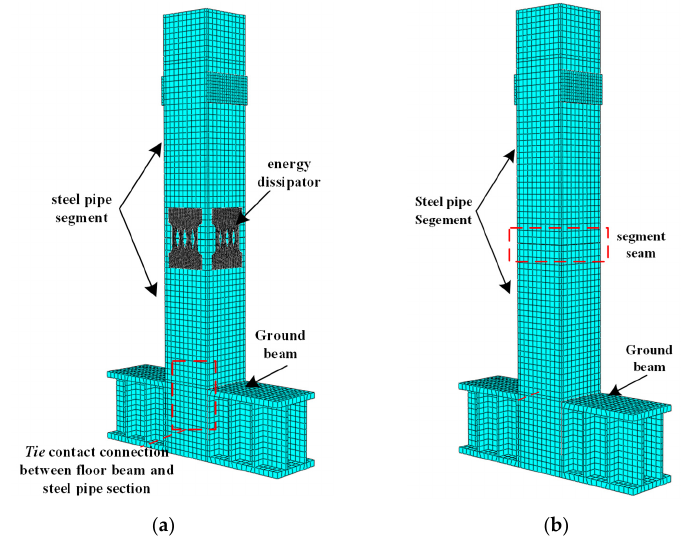
Figure 2. Finite element model, ( a ) CFST-R, ( b ) CFST-0.